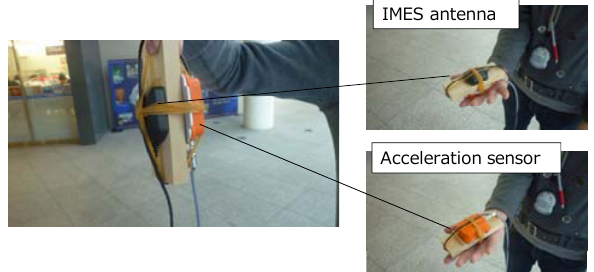
Figure 5. Combination of IMES receiver and acceleration sensors